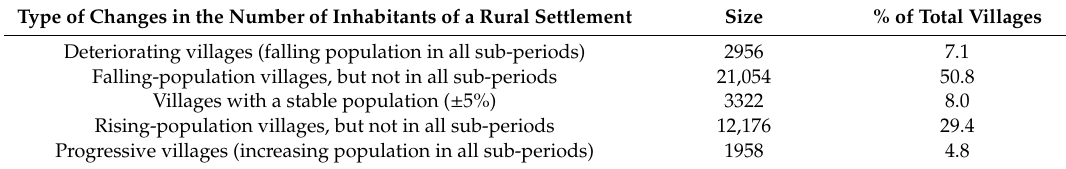
Table 1. Classification of villages by the nature of population